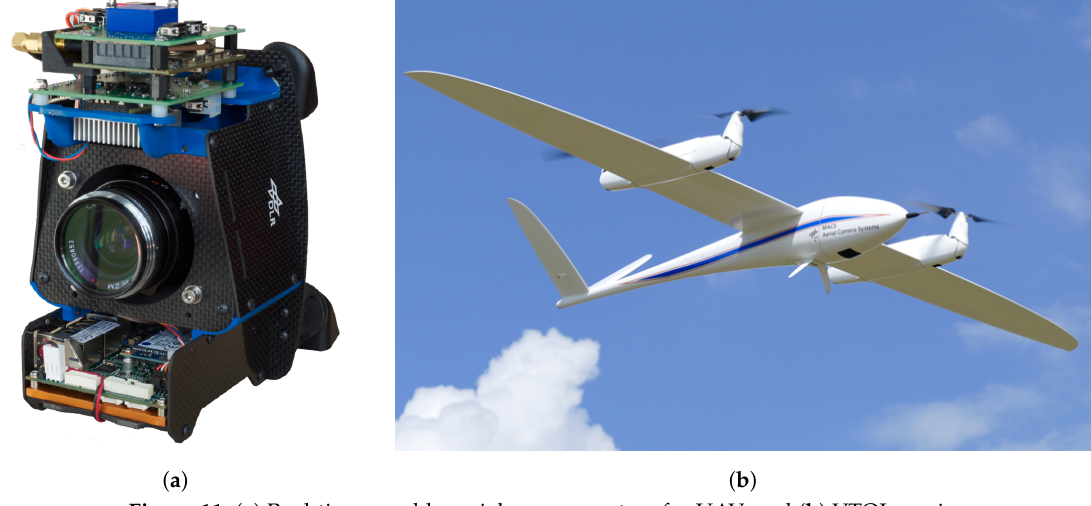
Figure 11. ( a ) Real-time capable aerial camera system for UAV; and ( b ) VTOL